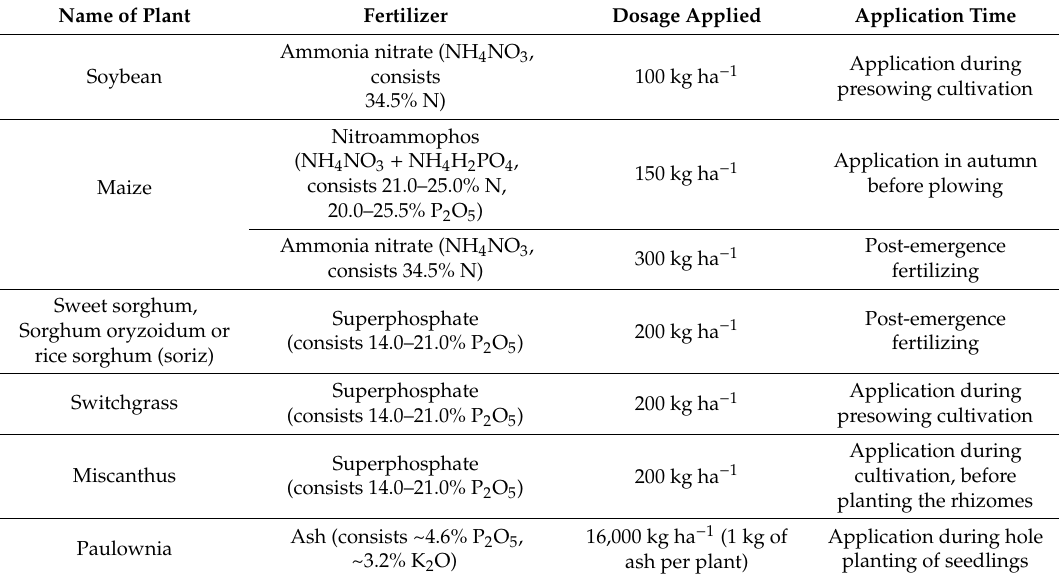
Table 2. Fertilizer application at the fields where the analysed bioenergy crops were